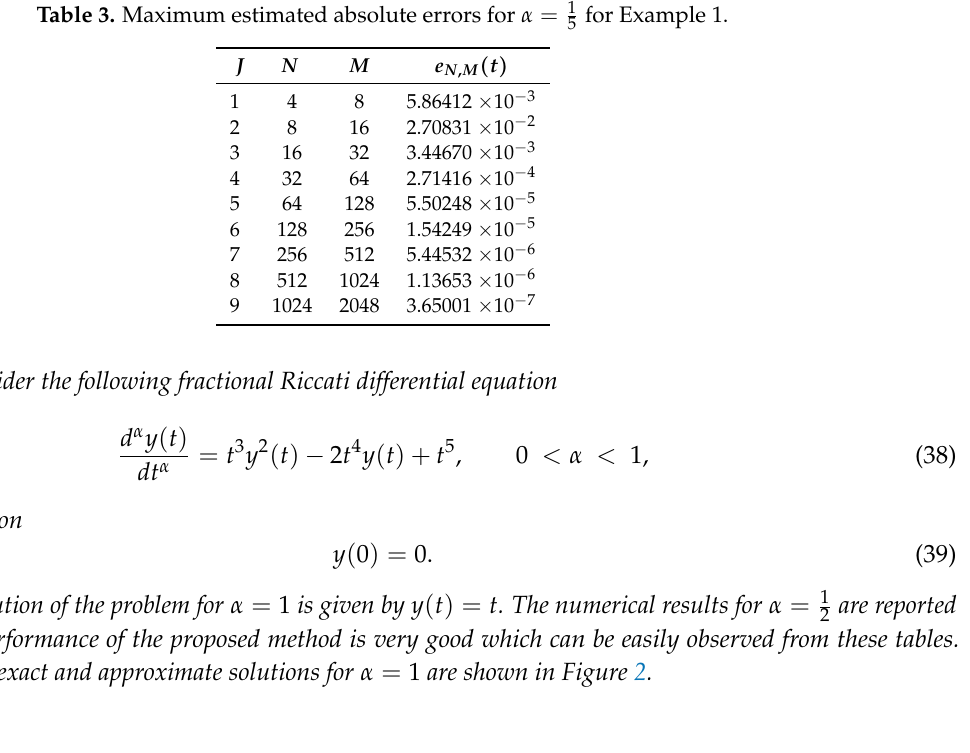
Table 3. Maximum estimated absolute errors for α = 1